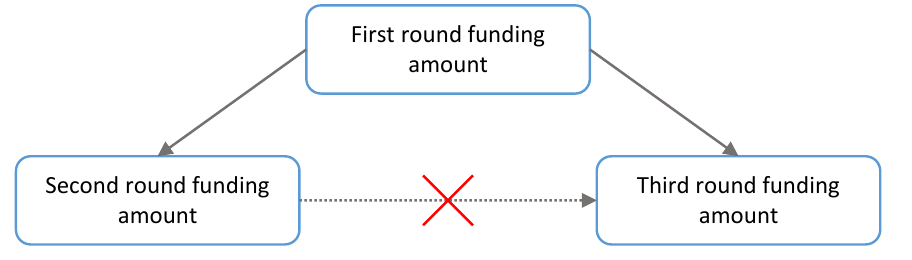
Figure 5. Inter-funding round dependencies Table 6. Relationships between amounts raised in each funding round